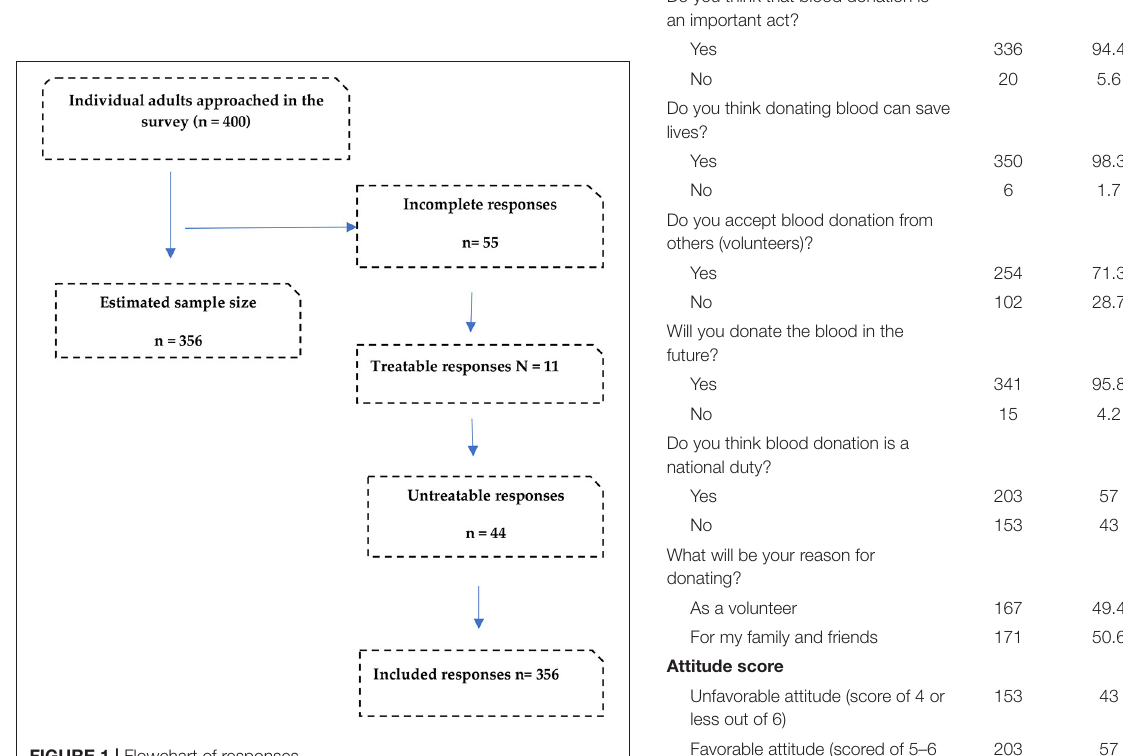
FIGURE 1 | Flowchart of